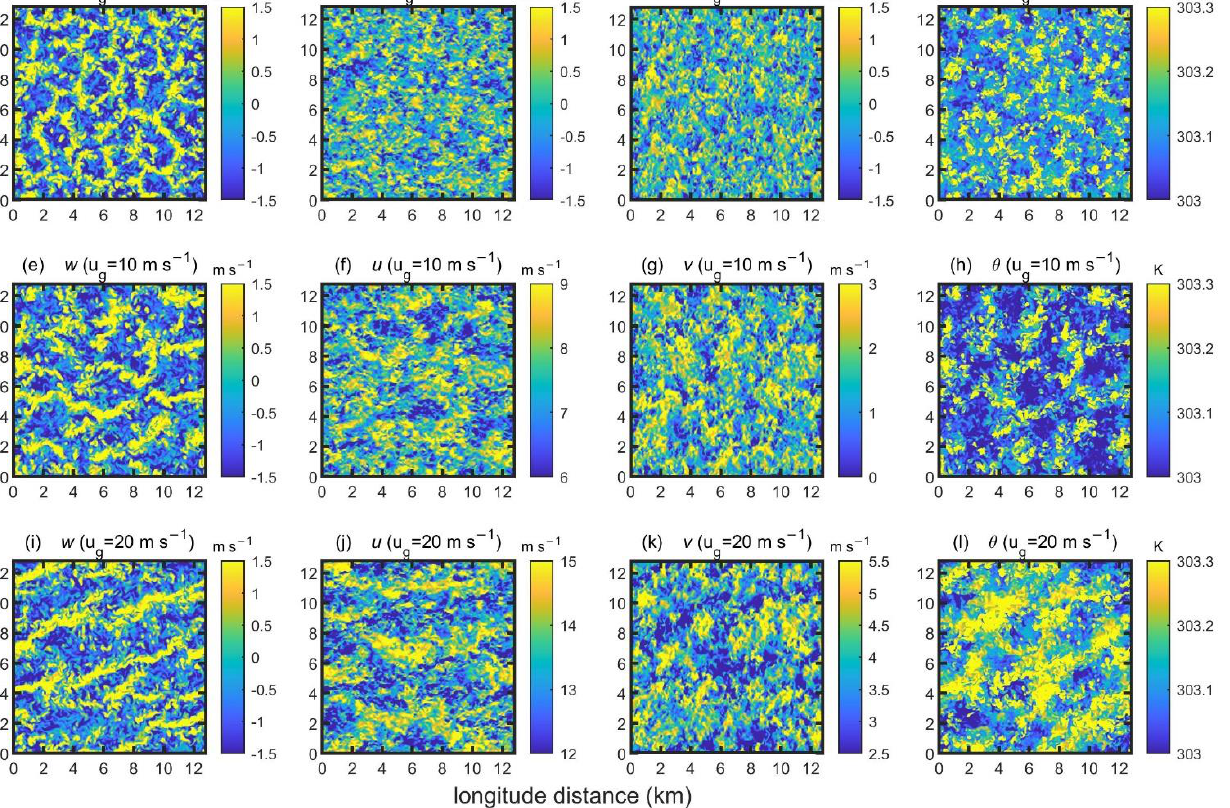
Figure 1. Instantaneous snapshots of velocity component w ( first column ), velocity component u ( second column ), velocity component v ( third column ), and potential temperature θ ( last column ) from LES simulations at z / z i = 0.5 and 3 h of physical time across the range of geostrophic wind speed. First row U g = 0 ms −1 ; second row U g = 10 ms −1 ; third row U g = 20 ms −1 . Note that the color scale on each plot is different for contrast and clarity.